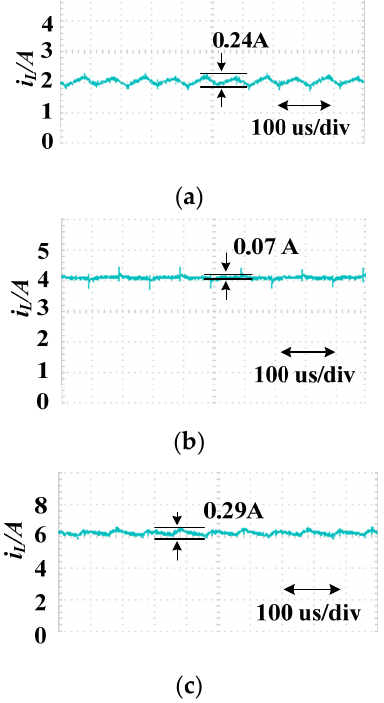
Figure 13. Experimental results of input current ripple characteristics of series circuit. ( a ) D = 0.3; ( b ) D = 0.5; ( c ) D = 0.6.